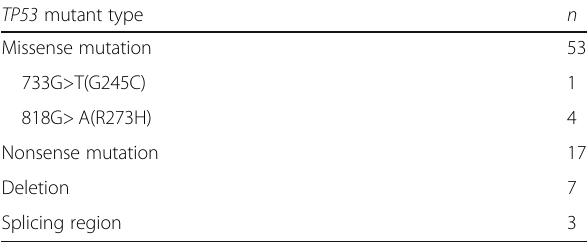
Table 1 TP53 mutation types in 88 ESCC cases of WGS